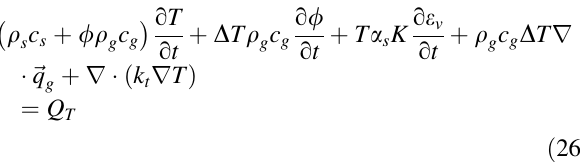
Fig. 1. The property parameters of coal and gas in the numerical model were shown in Table 1. The parameters